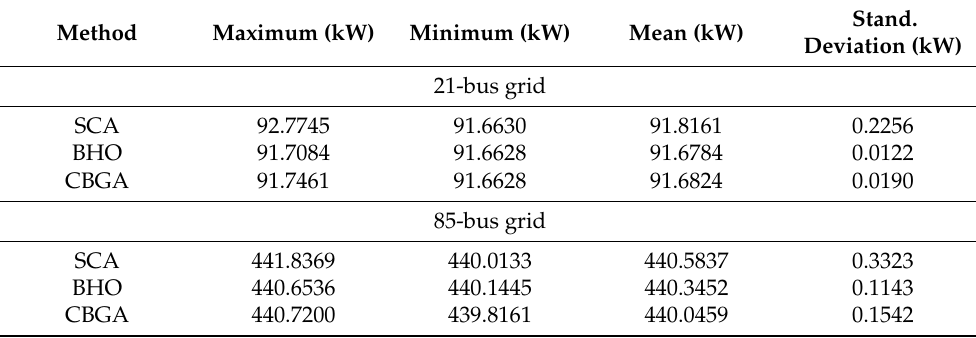
Table 5. Statistical behavior of the three metaheuristic optimizers in both test feeders after 100 consecutive